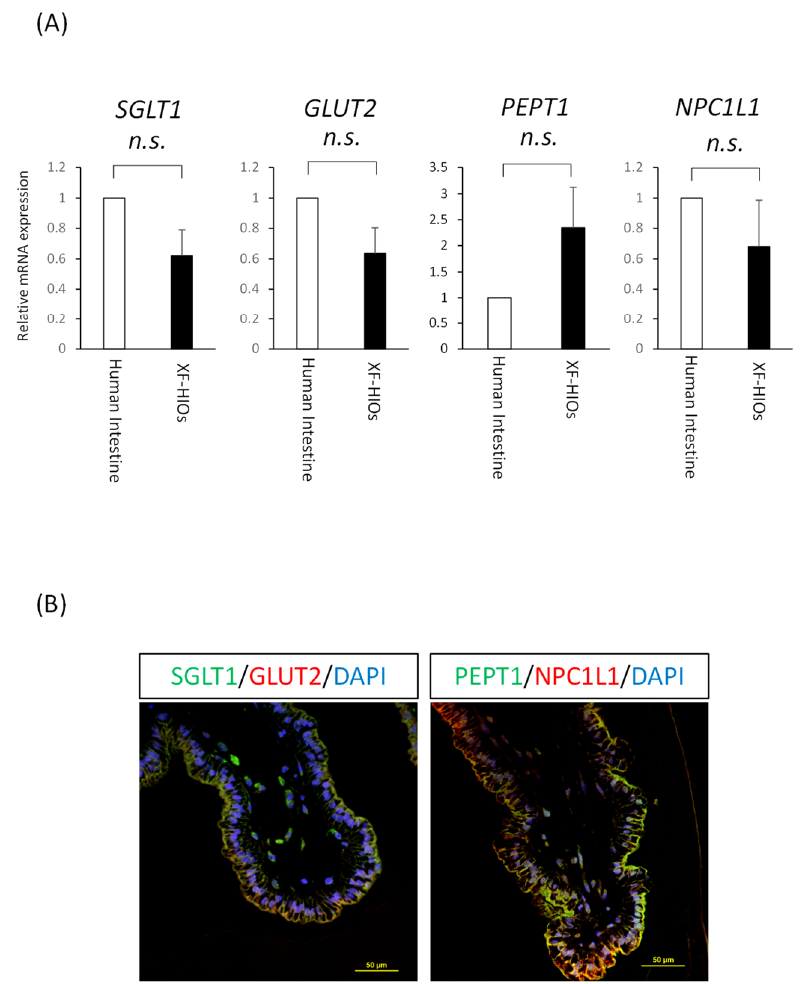
Figure 2. XF-HIOs possess nutrient-absorption-related transporters. ( A ) The level of expression of mRNAs for SGLT1, GLUT2, PEPT1, and NPC1L1 relative to the human small intestine. Data represent the mean ± S.E. values of three independent experiments. n.s., not significant. ( B ) Immunostaining images of three-dimensional xenogenic-free human intestinal organoids (XF-HIOs) with anti– Sodium/Glucose Cotransporter 1 (SGLT1), Glucose Transporter Type 2 (GLUT2), H+/oligopeptide